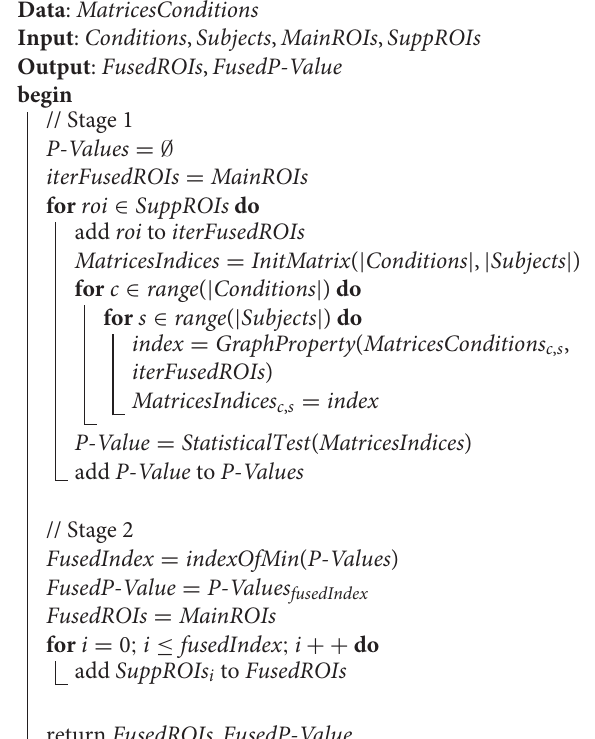
Algorithm 2: Cognitive networks